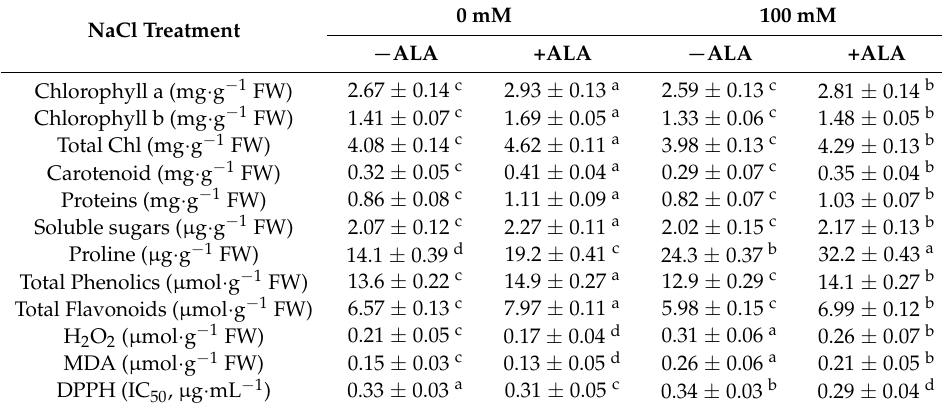
Table 5. Contents of chlorophylls, carotenoids, proteins, sugars, proline, phenolics, flavonoids, H 2 O 2 , MDA and antioxidant activity (DPPH) in leaves of Damseaux cultivar under salt and/or ALA (7 ppm)